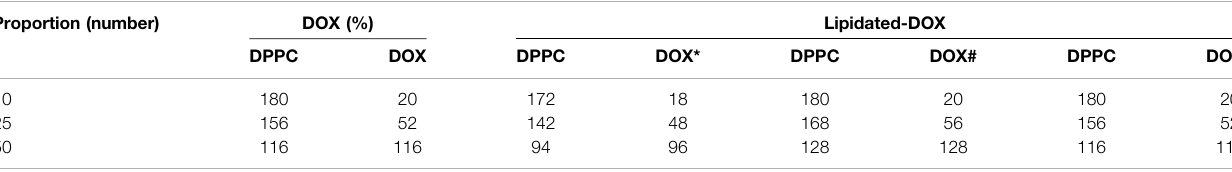
TABLE 1 | The composition of each ND formulation